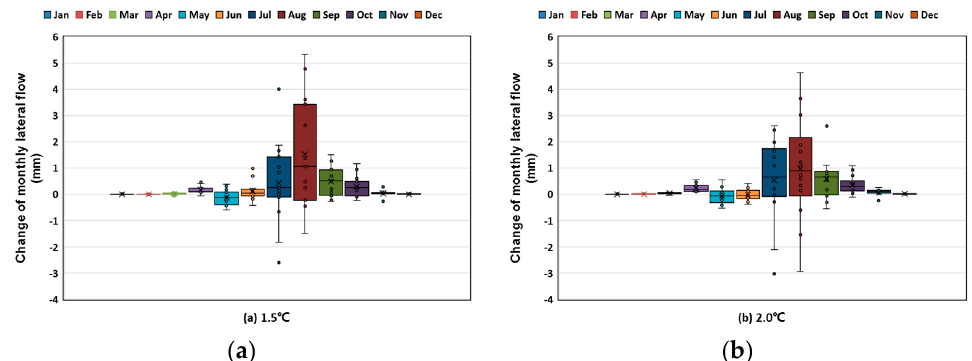
Figure 10. Change of monthly lateral flow refer to baseline period ( a ) 1.5 °C; ( b ) 2.0 °C.